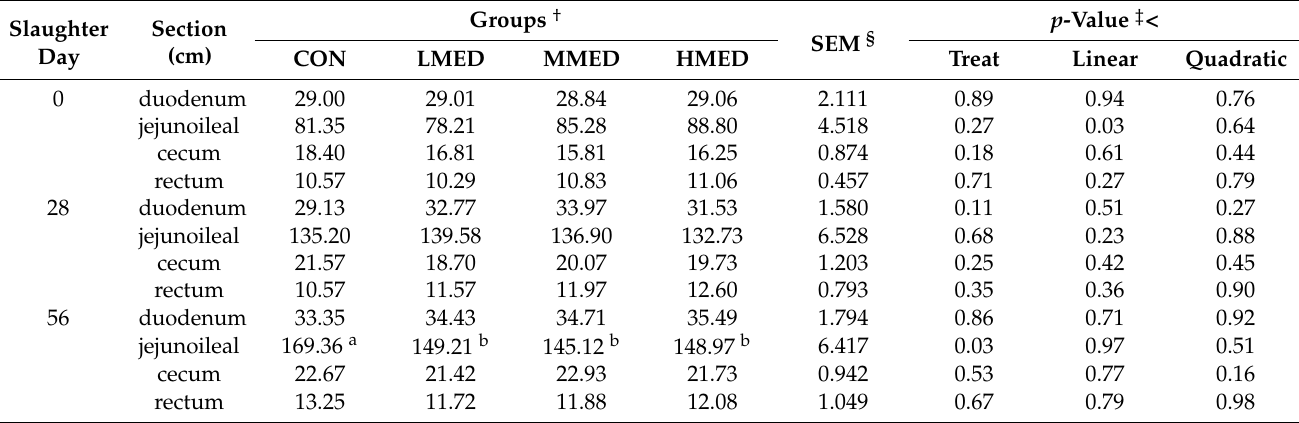
Table 6. Effects of supplemental feeding diets with three levels of metabolizable energy (ME) on length of section of digestive tract of grazing Swan